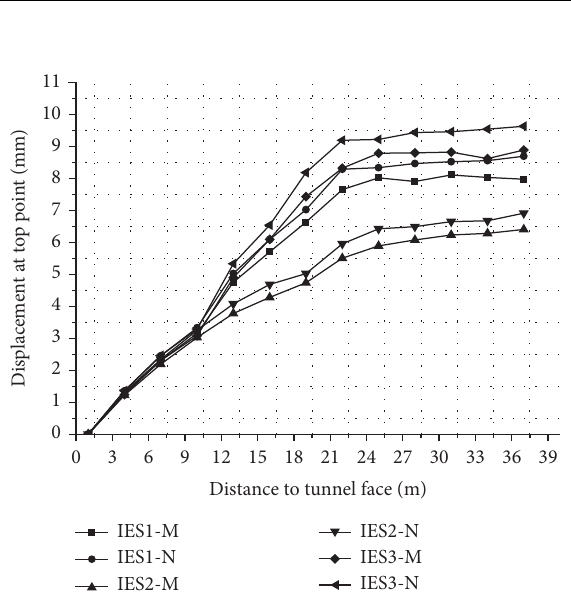
Figure 8: Displacement curves of the top point obtained by monitoring and numerical simulations.